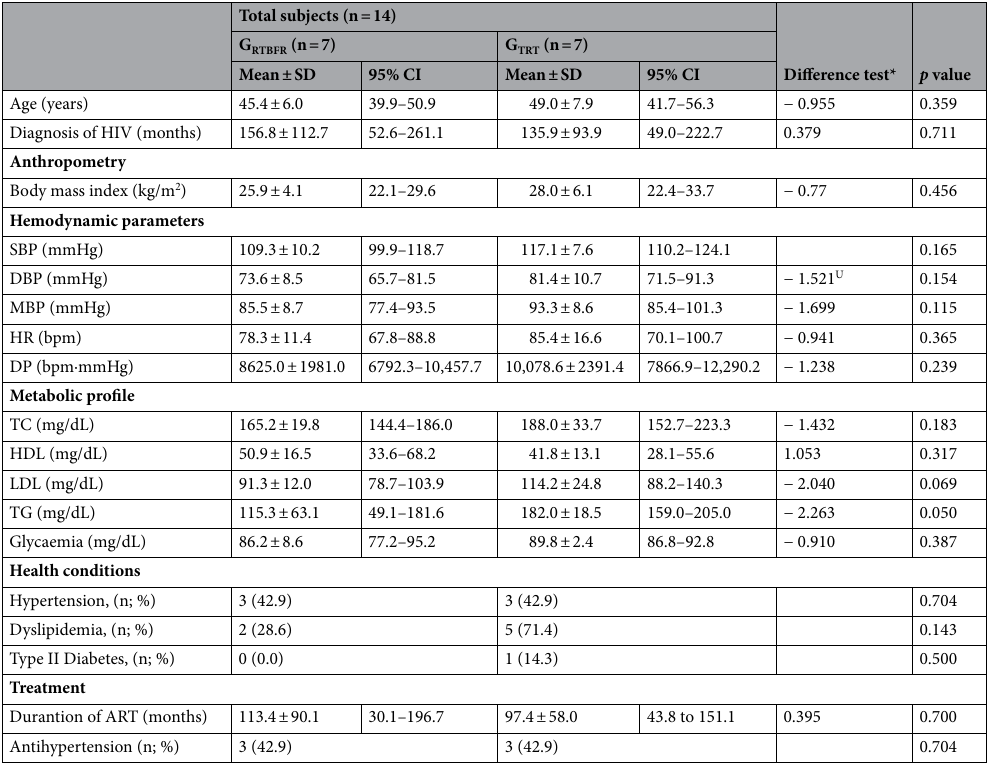
Table 1. Descriptive analysis and differences test between groups at baseline. NOTE : hemodynamic variables at rest. G RTBFR : group of resistance training with blood flow restriction; G TRT : group of traditional resistance training; HIV: human immunodeficiency virus; 95% CI: confidence interval; ART: antiretroviral therapy; (m): meters; (kg): kilograms; (kg/m 2 ): kilograms/meters square; (cm): centimeters. SBP: systolic blood pressure; DBP: diastolic blood pressure; MBP: mean blood pressure; HR: heart rate; DP: double product; TC: total cholesterol; HDL: high-density lipoprotein cholesterol; LDL: low-density lipoprotein cholesterol;